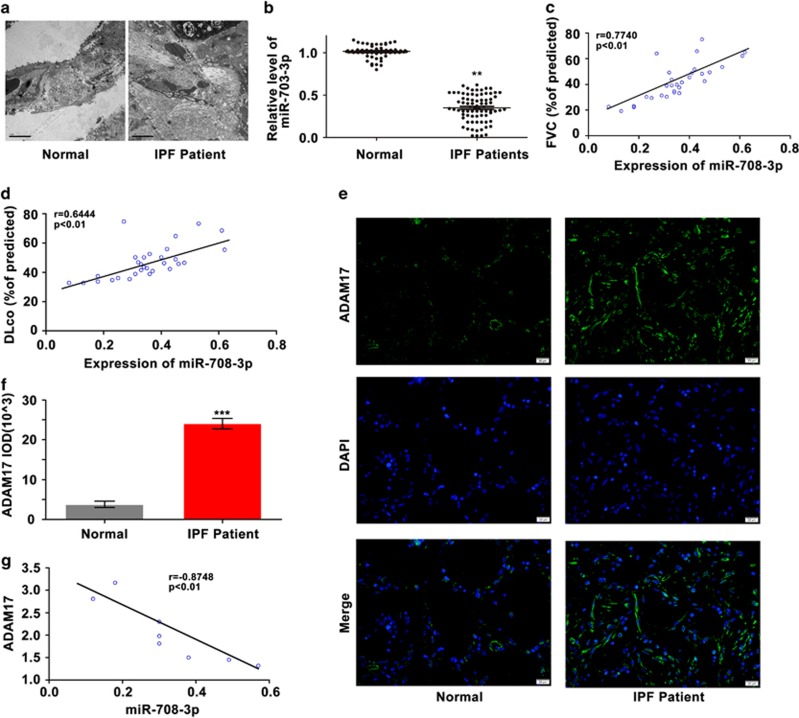
Clinical research of miR-708-3p in patients with IPF. (a) TEM showed an increased collagen amount in the patients with IPF relative to that in the normal subjects. (b) qRT-PCR confirmed that miR-708-3p expression was lower in the peripheral blood mononuclear cells of the patients with IPF than in those of the normal individuals. (c, d) MiR-708-3p levels positively correlated with FVC% and DLco%. Statistical analysis was performed using the Pearson correlation coefficient. (e, f) Immunofluorescence revealed that ADAM17 expression increased significantly in the patients with IPF compared with normal individuals. (g) Pearson correlation coefficient showed that miR-708-3p inversely correlated with ADAM17 in patients with IPF. Each bar represents mean±s.d.; n=6. ***P<0.01 compared with the normal group.